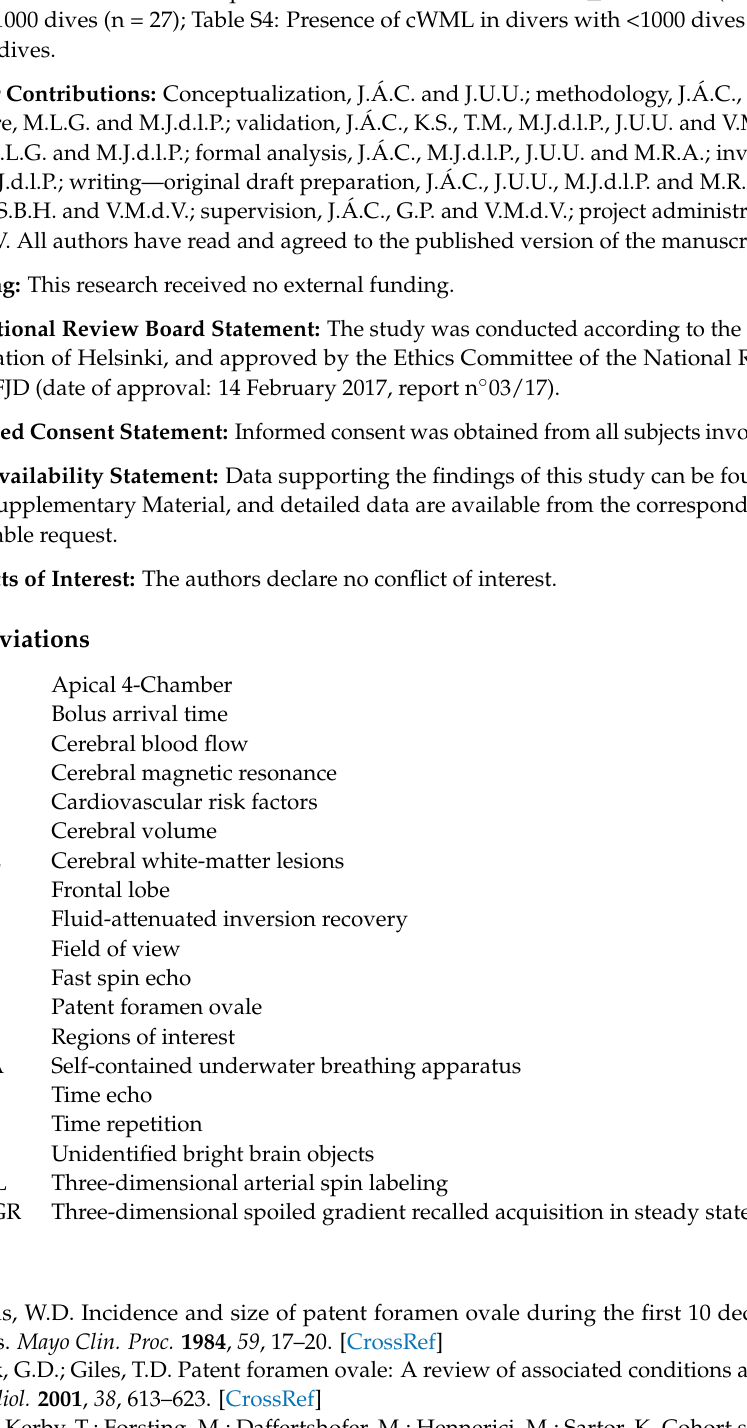
cording to PFO in the group of divers; Table S2: Cerebral blood flow correlation according to age; Table S3. Differences in CBF quantification between divers with ≥ 1000 dives (n = 11) and divers with <1000 dives (n = 27); Table S4: Presence of cWML in divers with <1000 dives and divers with ≥ 1000